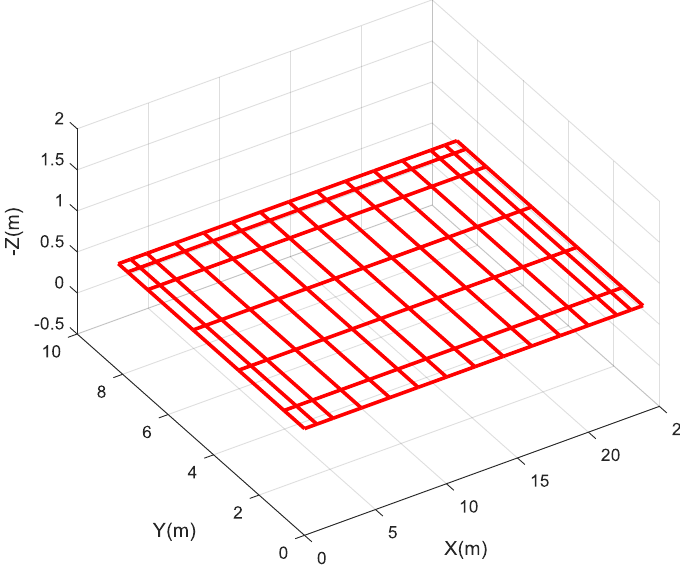
Figure 4. The Balaidos substation grounding grid.